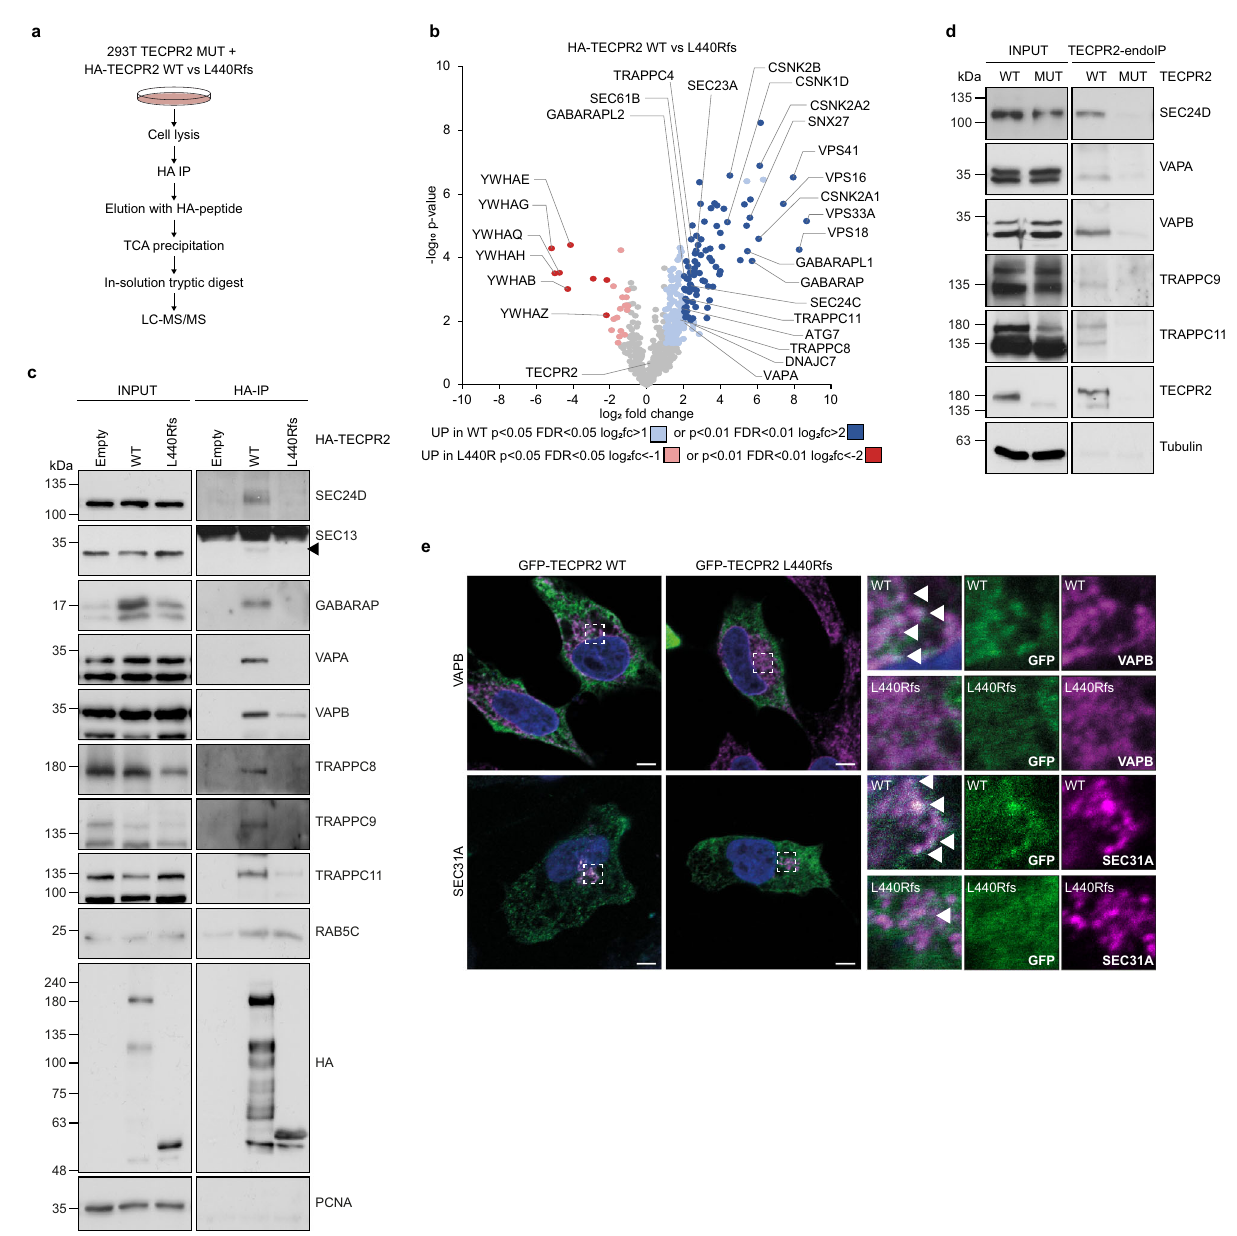
d Endogenous TECPR2 was immunoprecipitated from TECPR2 WT and MUT cell lysatesfollowedbyimmunoblotting.Tubulinservedasloadingcontrol. e HeLacells transiently transfected with GFP-TECPR2 WT or L440Rfs were fi xed and immuno- labeled.Insetsshowmagni fi cationofboxedareas.Scalebars10 µ m.Sourcedataare provided as a Source Data fi